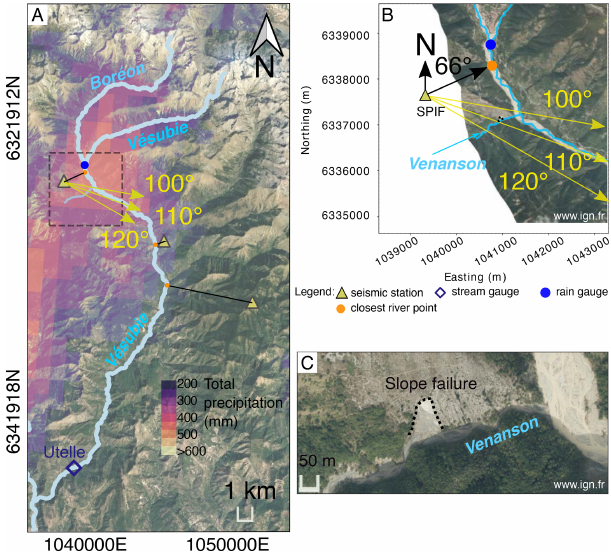
Figure B3. (a) Map section showing the Vésubie and the Boréon rivers. The 25km 2 square used for the rainfall calculation in Fig. 1b is shown with dashed black lines. Background map source: © Google Maps 2021. (b) Zoomed-in view of the square marked in panel (a) . Three dominant azimuths are indicated in yellow arrows, showing dominant noise directions of 100, 110, and 120 ◦ (source: IGN, 2020). (c) Zoomed-in view of the intersection between the Venanson stream and the Vésubie River, with a slope failure indicated that is adjacent to the Venanson stream (source: IGN, 2020).